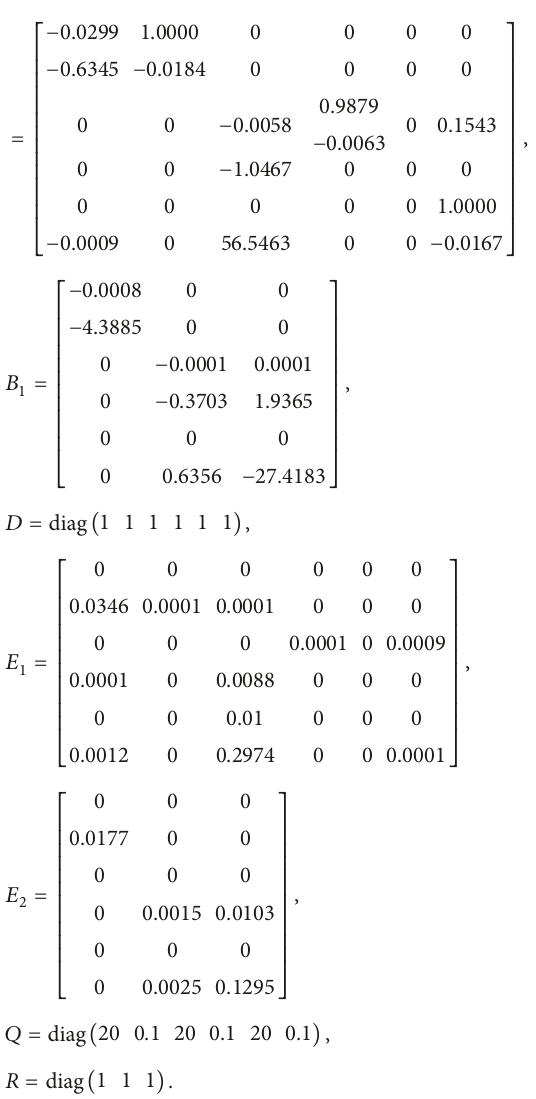
Figure 6 denotes the three channel angular velocity curves and Figure 7 is the curves of elevator and rudder angles in pitch, yaw, and roll channels. Figure 8 illustrates the regulating process of the control gain matrix 𝐾+Δ𝐾 elements, where Δ𝐾 is adjusted by the three SHLNN outputs. As